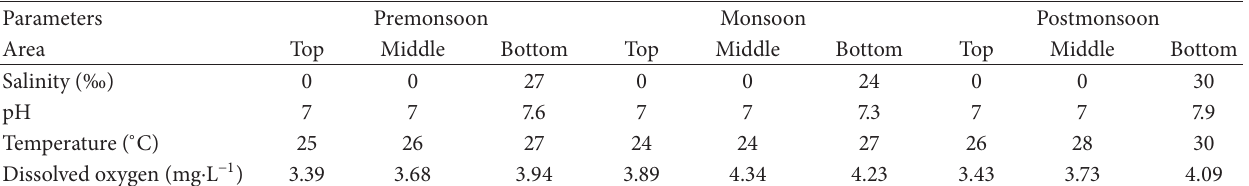
Table 2: Physicochemical properties of the water in the perennial stream.